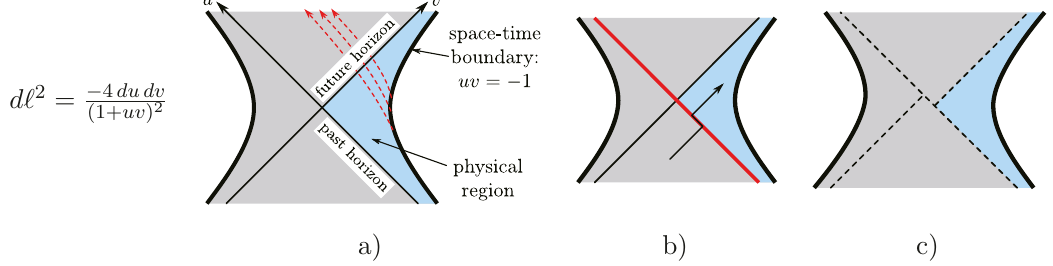
Figure 1 . (1 + 1)-dimensional black hole: a) Structure of space-time and infalling matter (shown as red dotted lines); b) The gravitational perturbations has turned into a “shock wave”; c) The same geometry in different